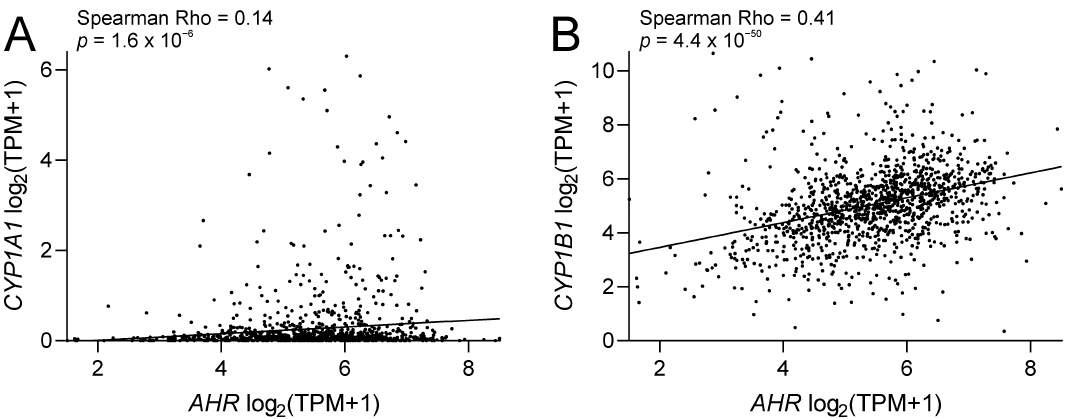
Figure 5. Scatter plots showing the relationship between aryl hydrocarbon receptor ( AHR ) and CYP1A1 ( A ) or CYP1B1 ( B ) gene expression, found both CYPs were significantly correlated with AHR in TCGA breast tumours ( n = 1222).